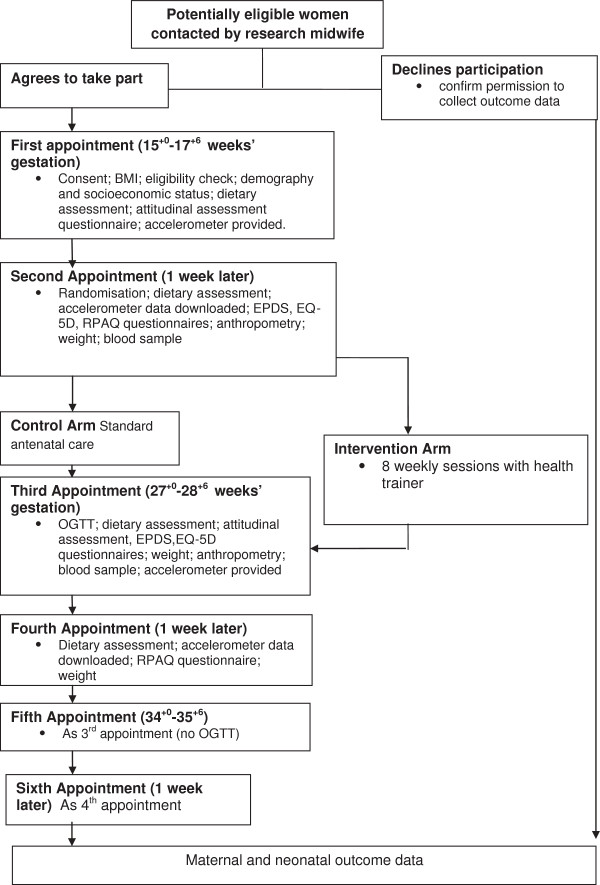
Study protocol. Abbreviations: BMI, Body Mass Index; EQ-5D, EuroQuol Quality of Life Questionnaire; EPDS, Edinburgh postnatal depression score questionnaire; OGTT, oral glucose tolerance test; RPAQ, Recent Physical Activity Questionnaire.